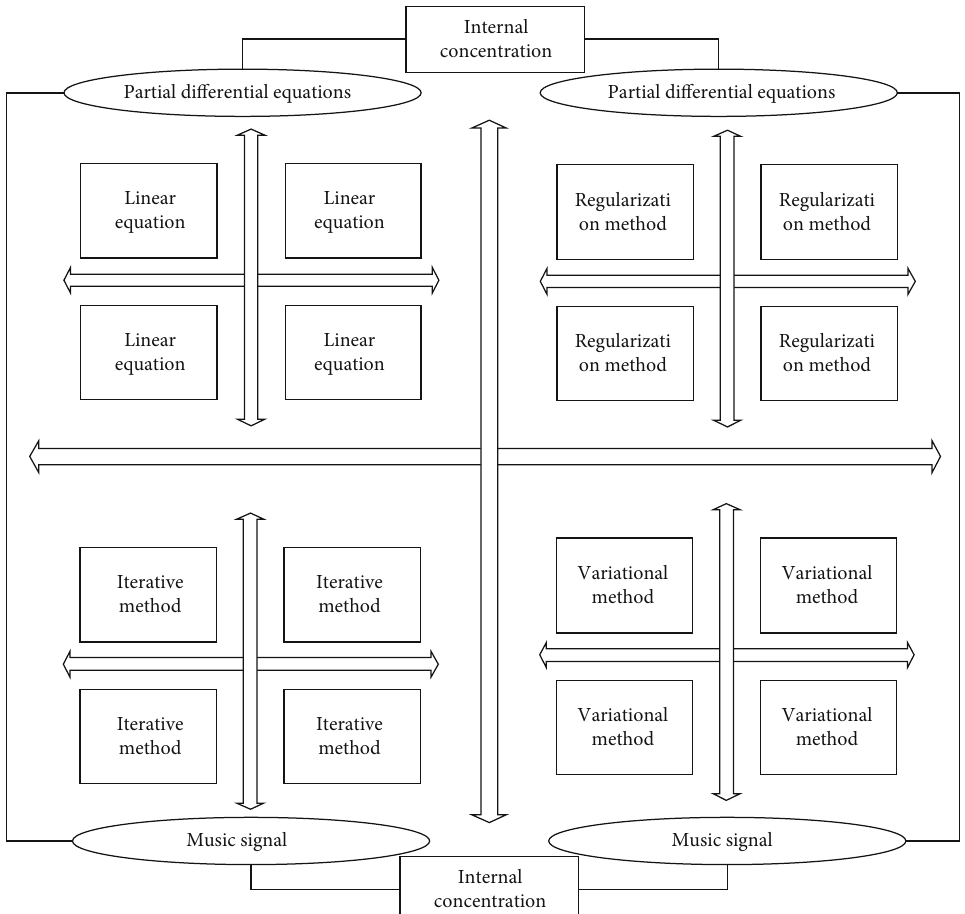
Figure 1: The spatial distribution of the solution set of partial di ff erential